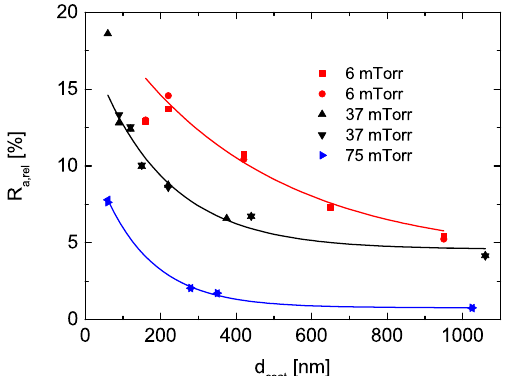
Figure 28. AFM measurements of layers which have been deposited with same partial pressure of p -xylylene N, but different dilution with argon. ( 1 ): pure (6 mTorr, 0.8 Pa), ( 2 ): 37.5 mTorr (5 Pa), ( 3 ): 75 mTorr (10 Pa).